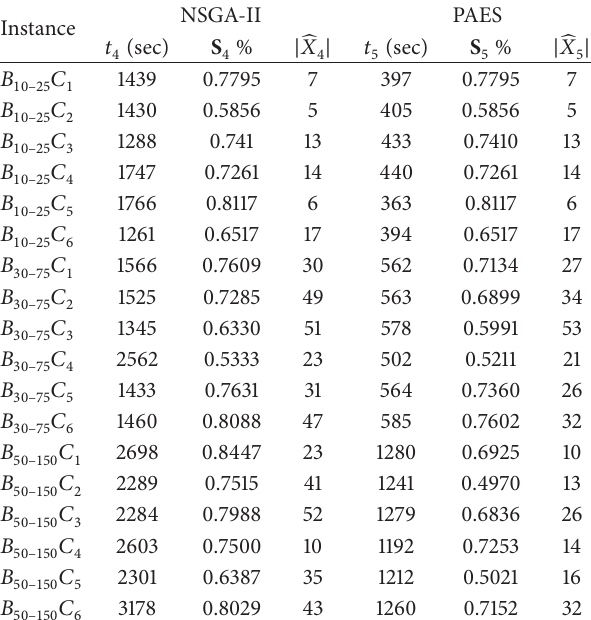
Table4:Resultsobtainedbywell-knownMOEAalgorithmsNSGA- II and PAES for instances of class 𝐵 .